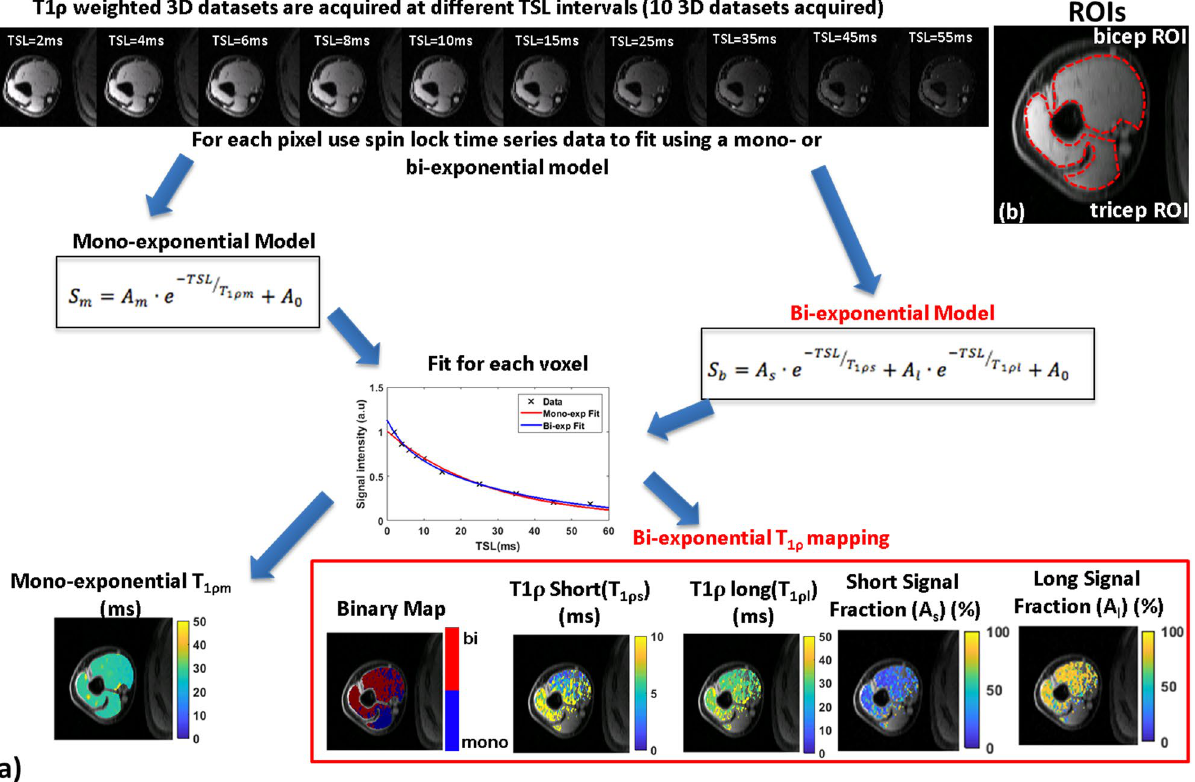
Figure 5. Post-processing pipeline for T 1ρ mapping. ( a ) shows a schematic representation of the T 1ρ mapping pipeline. T 1ρ weighted image time series data acquired at a range of spin-lock times are used. Mono-exponential modeling uses a three parameter fit producing T 1ρm parameter map. Bi-exponential model uses the same data and uses a five parameter fit to perform the modeling to generate a binary map showing voxels displaying mono- or bi-exponential relaxation, T 1ρs , T 1ρl , and relative signal fractions (A s and A l ). The ROIs used for the biceps and triceps are shown in ( b